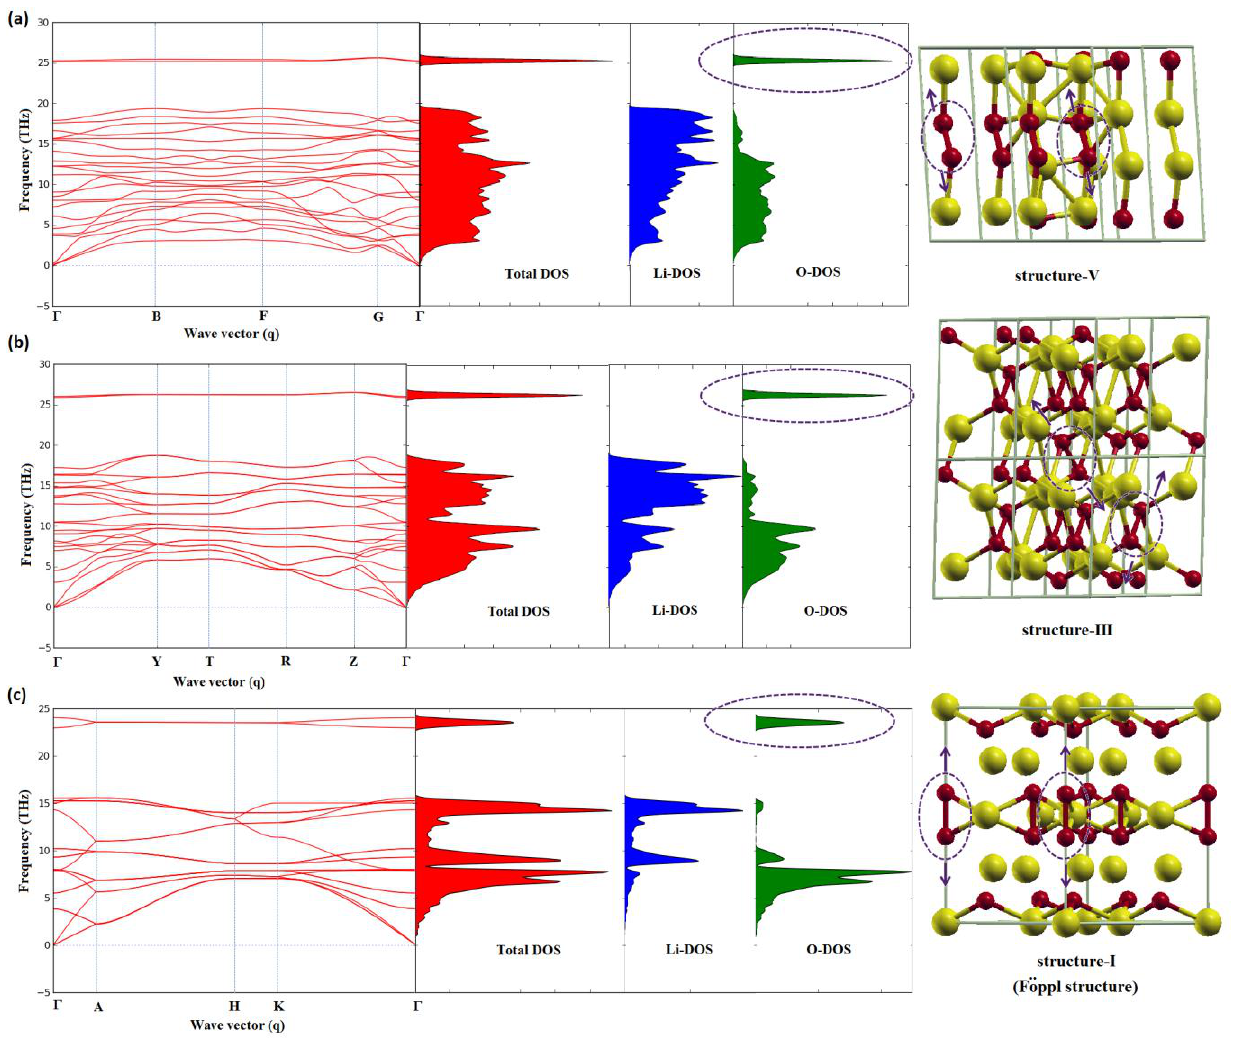
Figure 6. The phonon dispersion and phonon density of states (DOS) ( i.e. , total DOS in red, Li-DOS in blue, and O-DOS in green color) of three representative Li 2 O 2 crystalline phases: ( a ) structure-V in P1 space group; ( b ) structure-III in Cmce space group and ( c ) structure-I (Föppl structure in 𝑃6̅ space group). The purple highlighted DOS is the common signature of O-O stretching of an O 22− anion in the